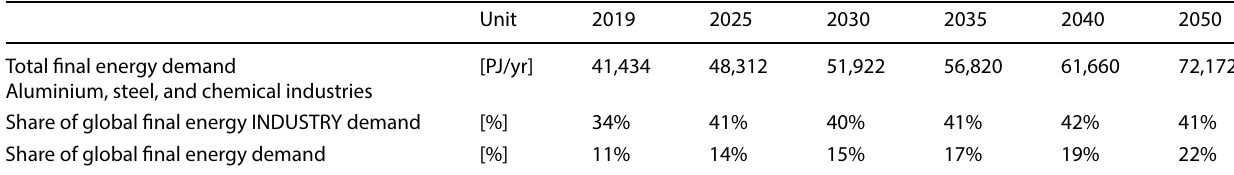
Table 17 Total global final energy demand in the aluminium, steel, and chemical industries